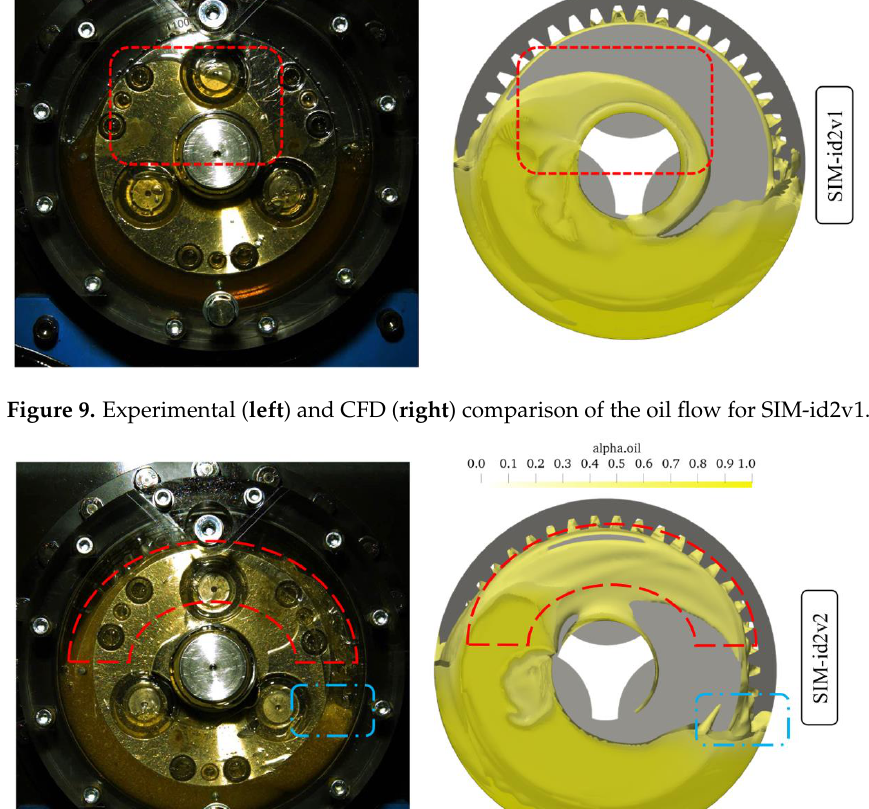
Figure 11. Experimental ( left ) and CFD ( right ) comparison of the oil flow for SIM-id2v3.